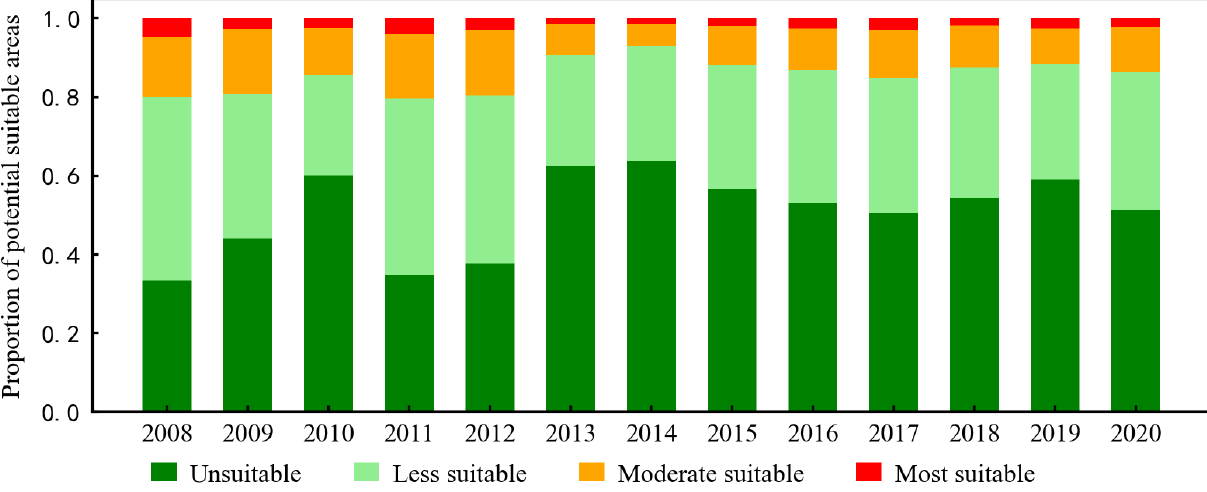
Figure 6. Proportions of area with different levels of suitability for grasshoppers.